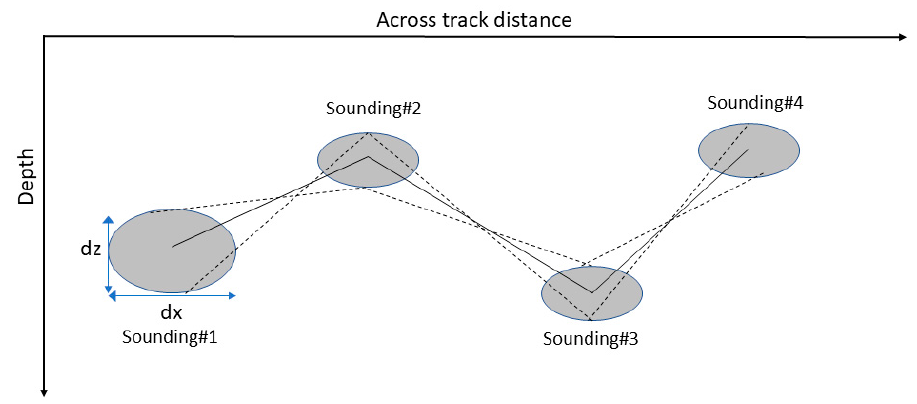
Figure 3. Incorporation of horizontal and vertical uncertainties in the slope estimation.